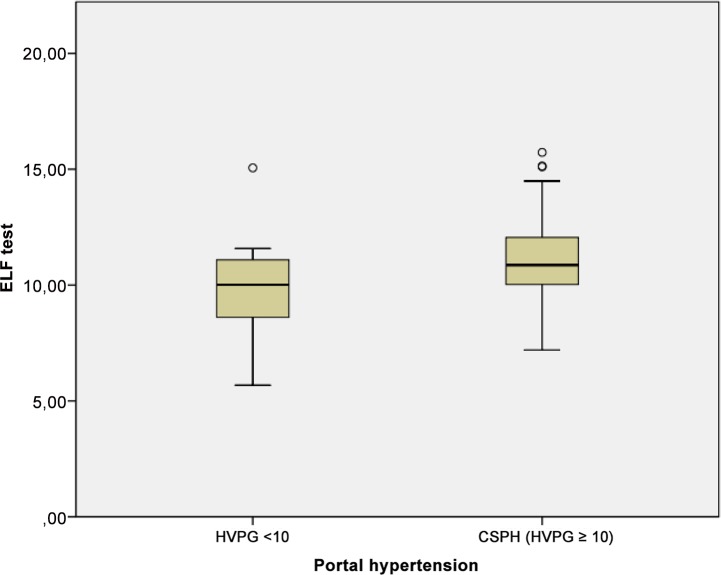
Correlation of enhanced liver fibrosis test (ELF) test and CSPH.Mean values of ELF test shown in boxplots for a cohort of patients with and without CSPH each.